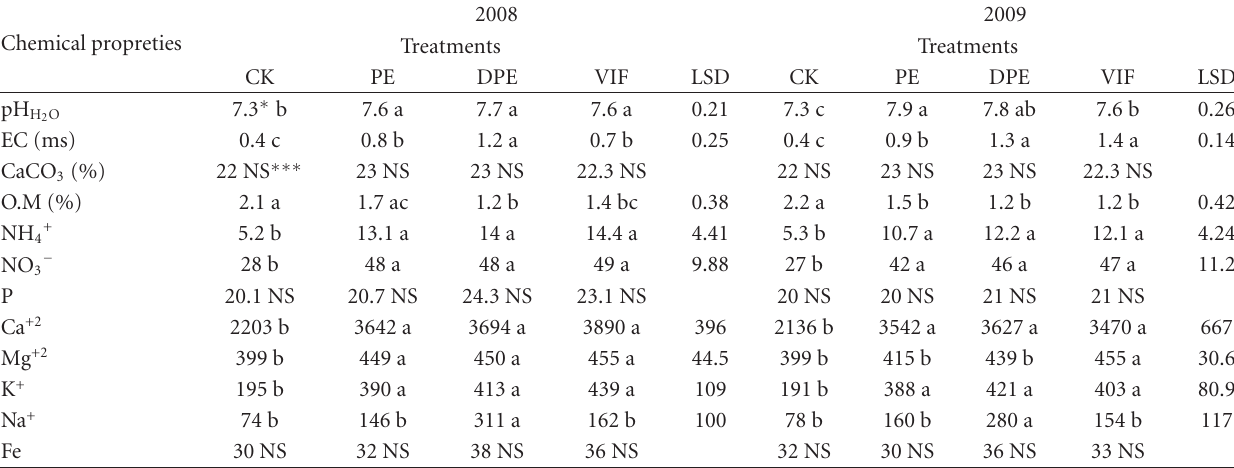
Table 5: E ff ect of solarization with regular polyethylene (PE), double regular polyethylene (DPE), and virtually impermeable films (VIF) on chemical properties of